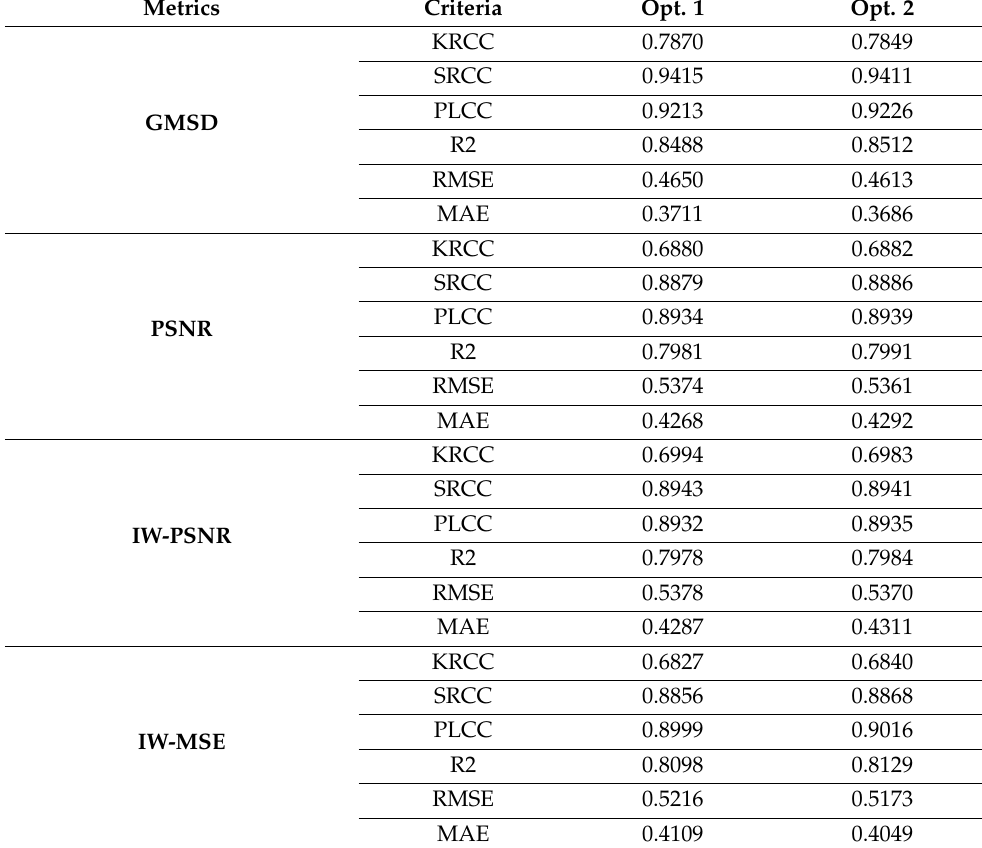
Table 6. Performance of the proposed model in different